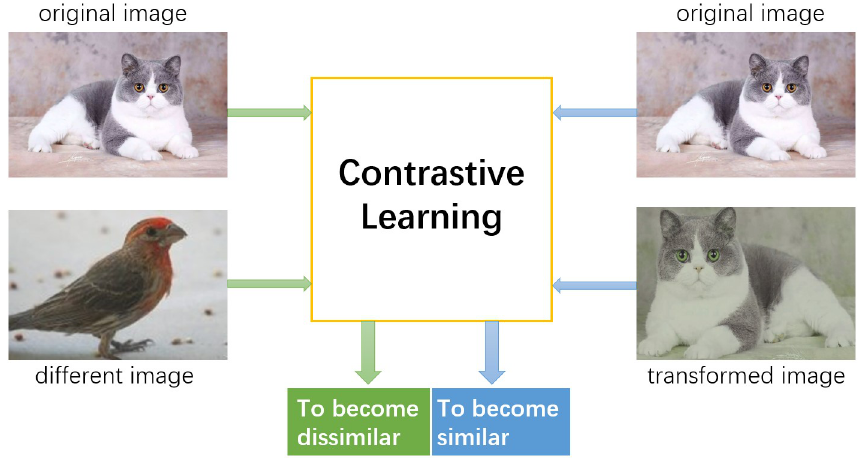
Figure 2. The core idea of contrastive learning: pushing the representations of original and trans- formed images closer together while separating the representations of original and different images far apart from each